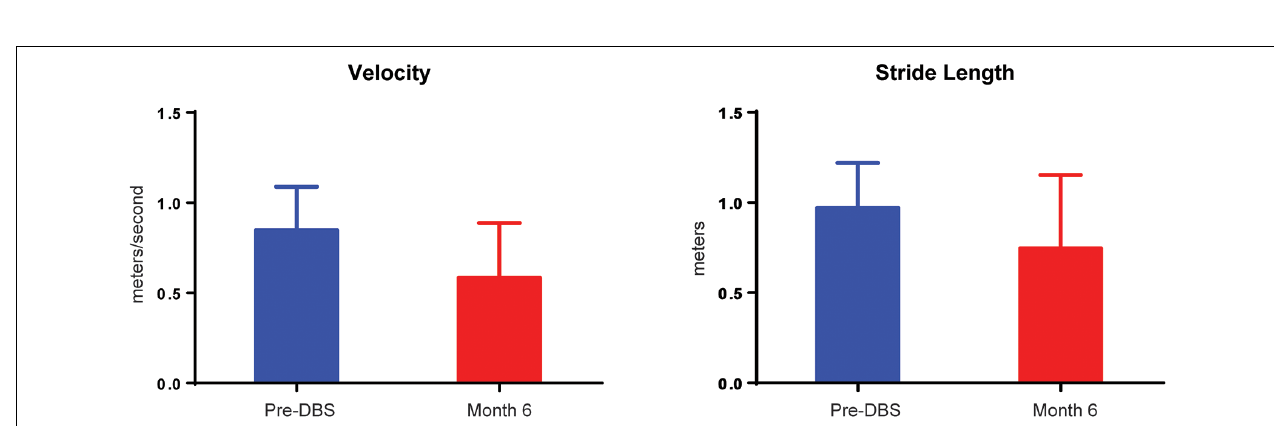
FIGURE 4 | Velocity and stride decrements in five subjects. A comparison of pre-DBS ( blue ) and 6 months ( red ) demonstrated no significant changes in gait velocity (in meters per second) or stride length (in meters). All data are plotted as µ + SD.